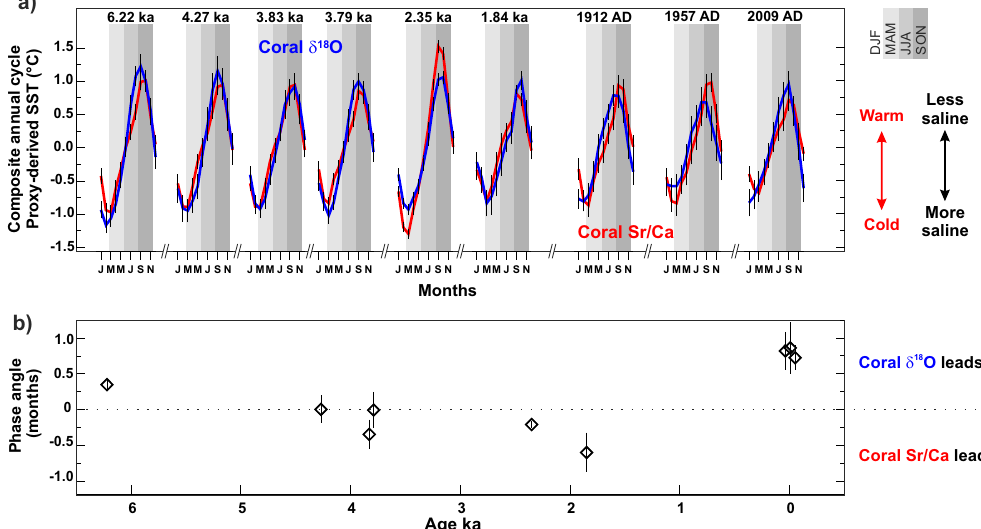
Fig. 5. (a) Composite annual cycles of coral Sr/Ca and δ 18 O for each coral record used in this study converted in degree Celsius by using Sr/Ca-SST and δ 18 O–SST relationships of − 0.061mmolmol − 1 ◦ C − 1 and − 0.180‰ ◦ C − 1 (Corr`ege, 2006; Gagan et al., 1998). Error bars indicate the standard error of the mean calculated for individual months. (b) Phase angles of the annual cycles estimated by cross-spectral analyses between monthly coral Sr/Ca and coral δ 18 O time series. Error bars indicate the 80% confidence